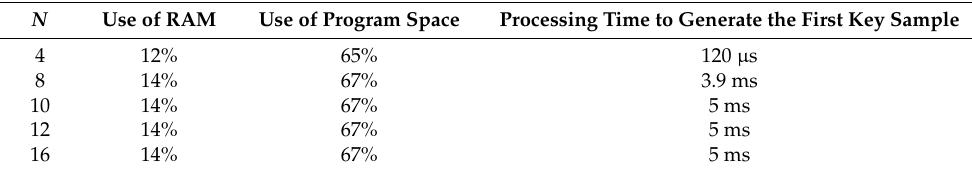
Table 2. Resource consumption. Results from the fifth experiment.